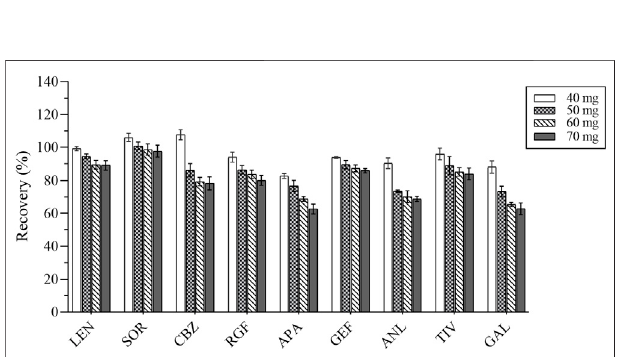
FIGURE 2 | The recovery results of all analytes for different extraction solvents.